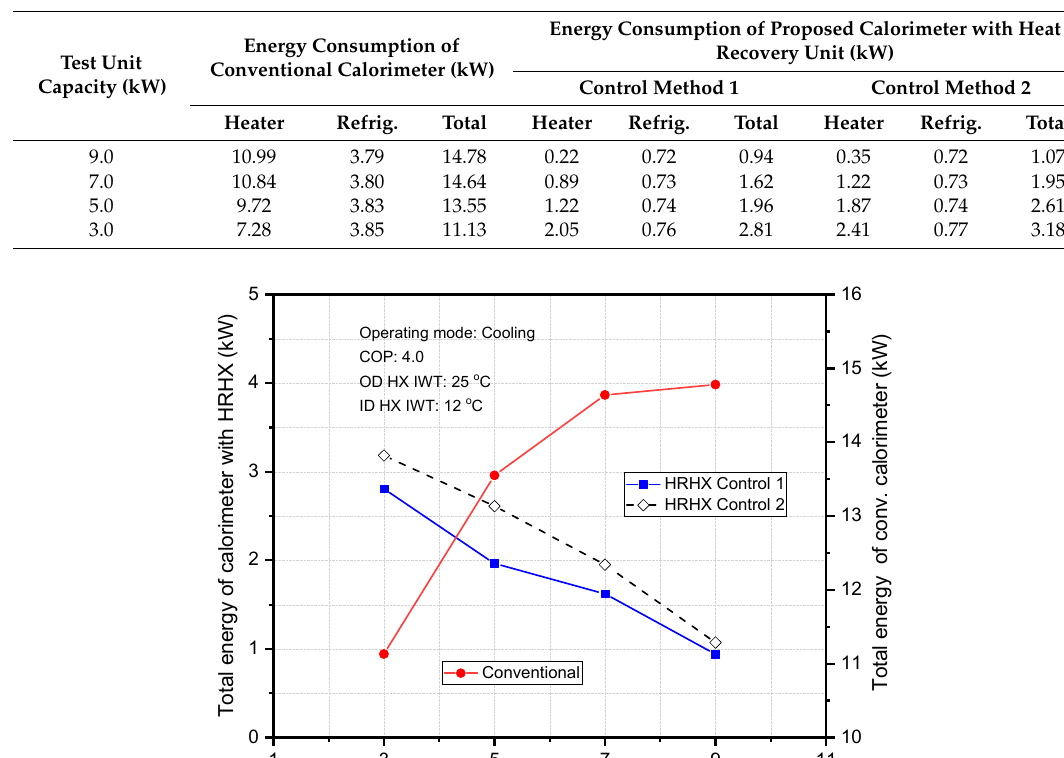
Table 4. Energy consumption data for a conventional calorimeter and the proposed calorimeter with Figure 13. Calorimeter energy consumption with variation in heat pump cooling capacity for control (2). heat recovery unit in cooling mode.